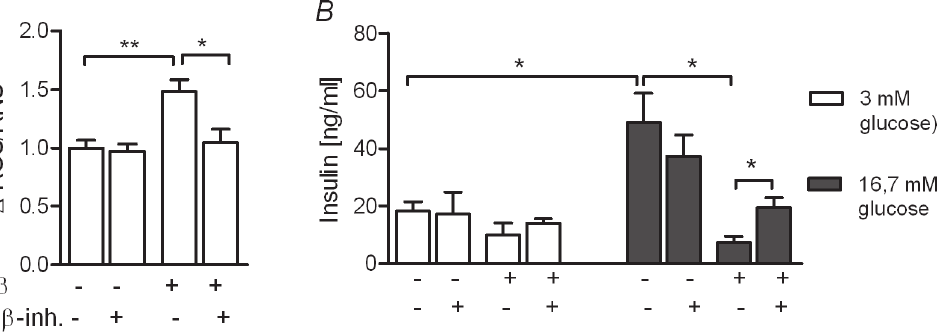
Figure 4. Islets from P.obesus are rescued from of IL-1 b induced ROS production and diminished insulin production by an IKK b - inhibitor. A : Islets from healthy adult P. obesus were incubated in the presence and absence of L-1 b and the IKK b -inhibitor for 24 hours before ROS was measured. B : GSIS was performed after 6 days incubation in the present or absent of IL-1 b and the IKK b -inhibitor. All data are shown as the mean 6 S.E.M. (*p , 0,05; **p , 0,01; ***p , 0,001).